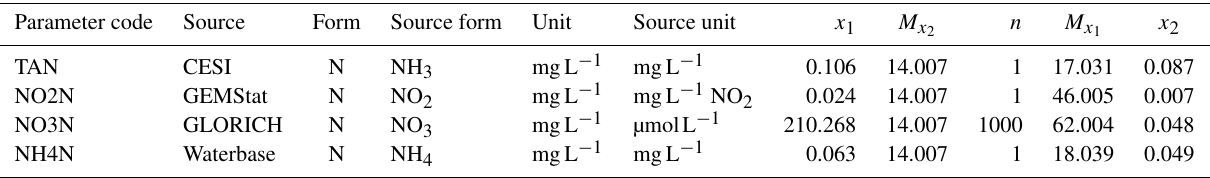
Table 4. Examples of unit conversion from the chemical form in source data to the GRQA version; x 1 and x 2 are observation values before and after conversion,